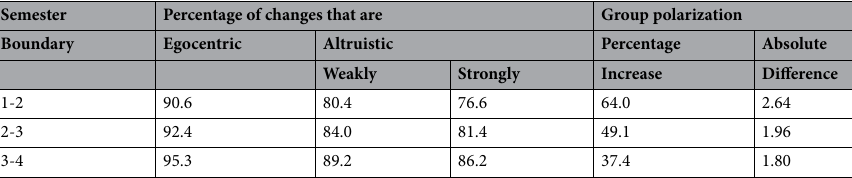
Table 2. Dynamics of altruism and group polarization. Analysis of the total number of altruistic changes and the growth of group polarization across the three semester